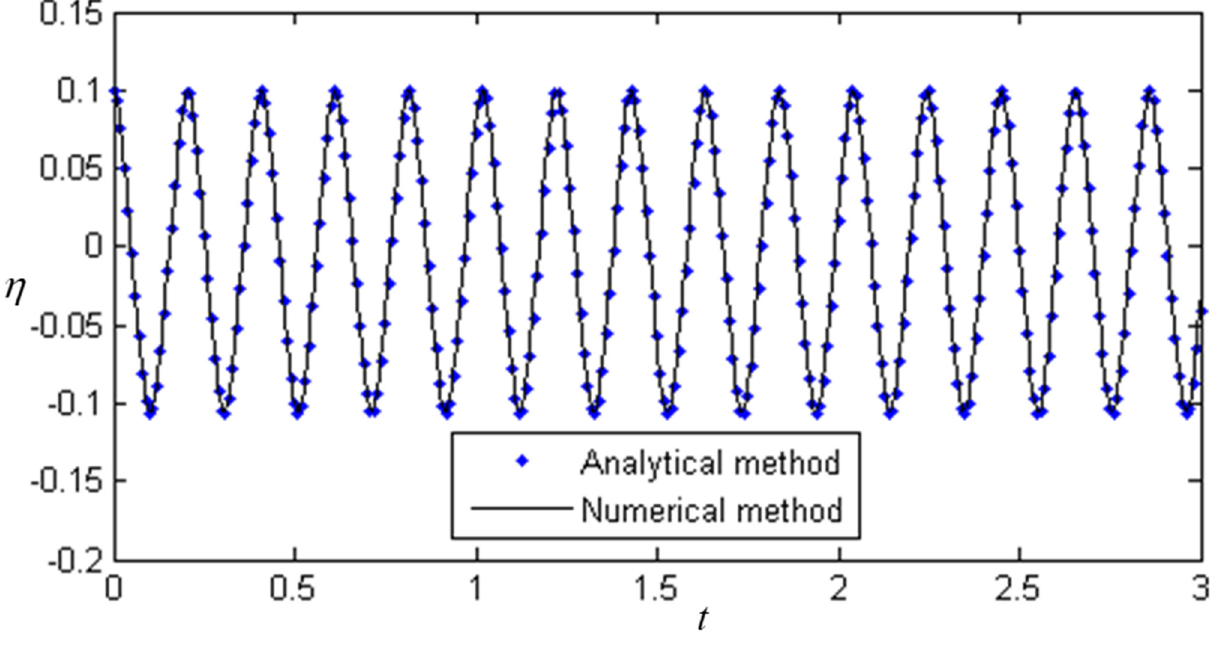
Figure 10. Comparison between the supercritical analytical solution (57) and the numerical solution for strongly nonlinear cases.